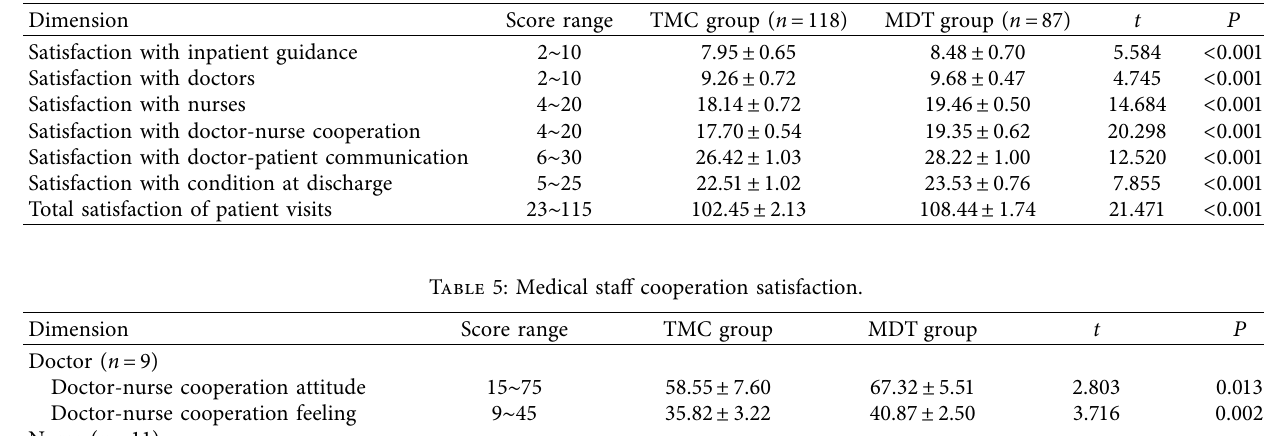
Table 4: Patient visit satisfaction.